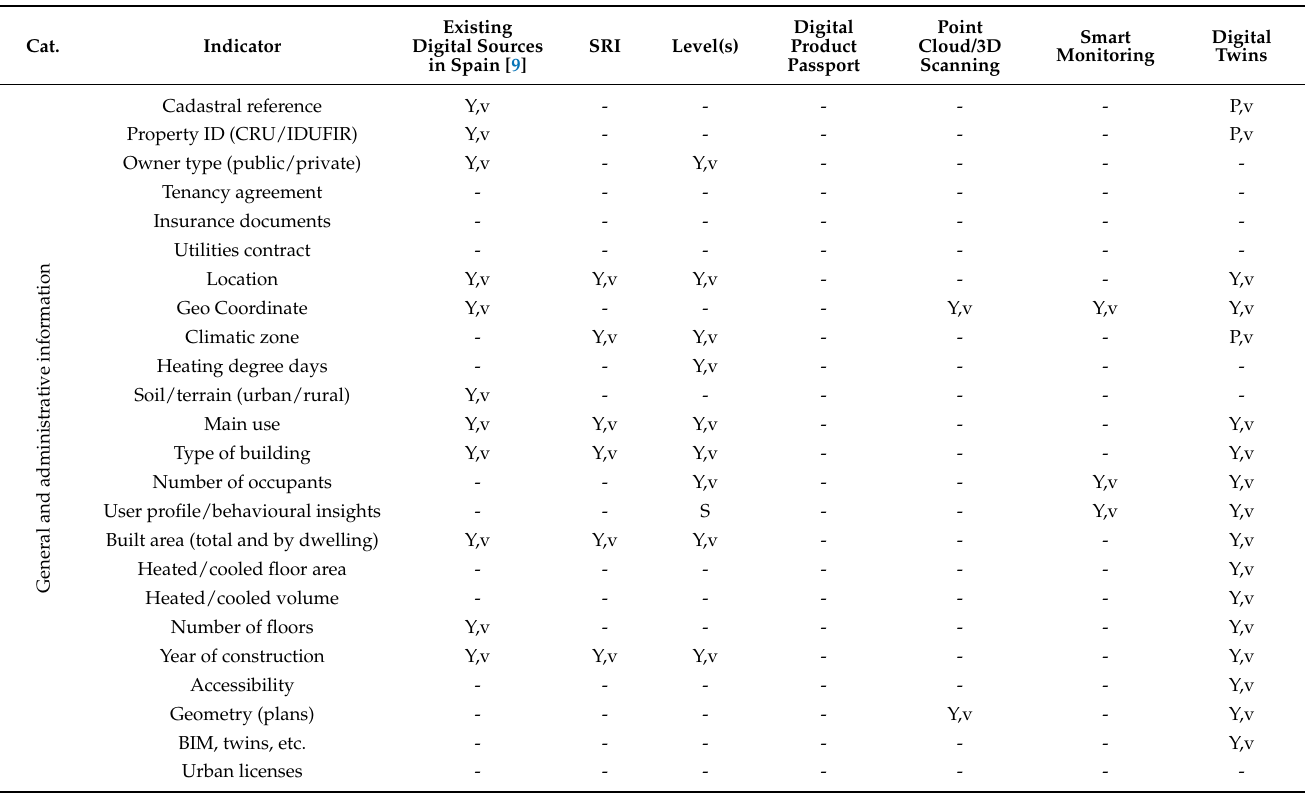
Table A1. Category 1: General and administrative information.